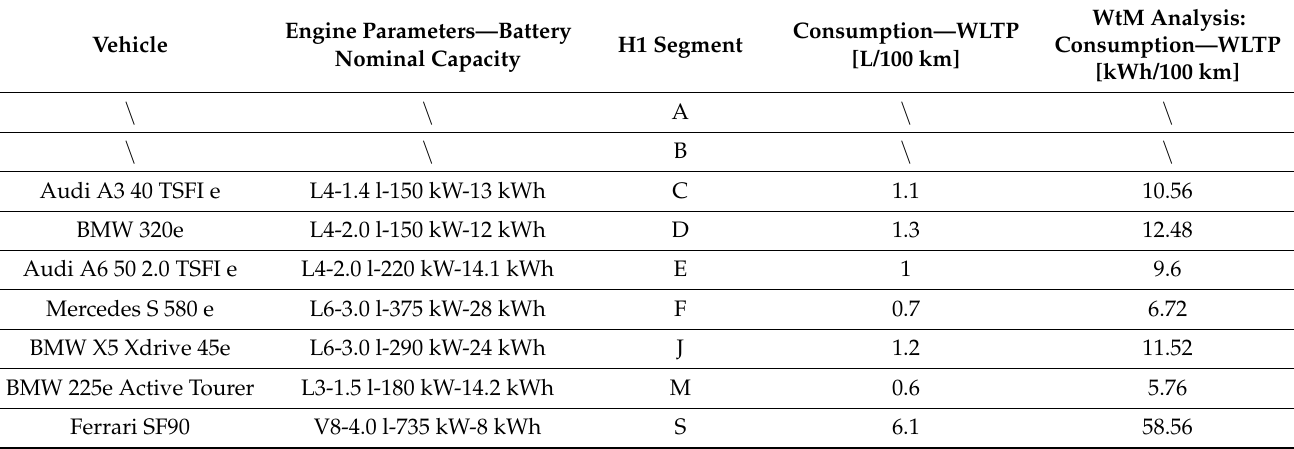
Table 9. Passenger vehicle fleet in Europe: division into powertrain and H1 segments—Powertrain: PEV [15,17,18]—Consumption value refers to fuel